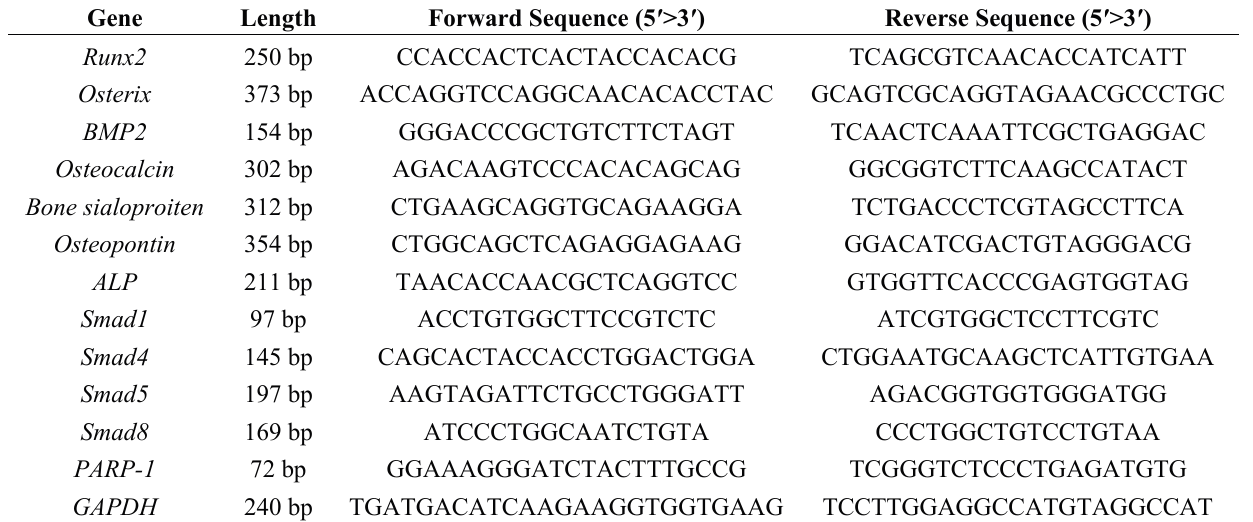
Table 1. Sequence of primers used in real-time